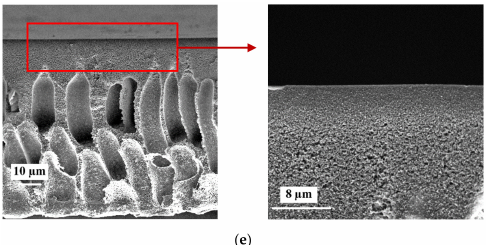
Figure 3. SEM microphotographs of the cross-section of the reference and modified membranes and enlarged fragment of cross-section in the vicinity of the selective layer: ( a )—SA-0; ( b )—SA-0.7;